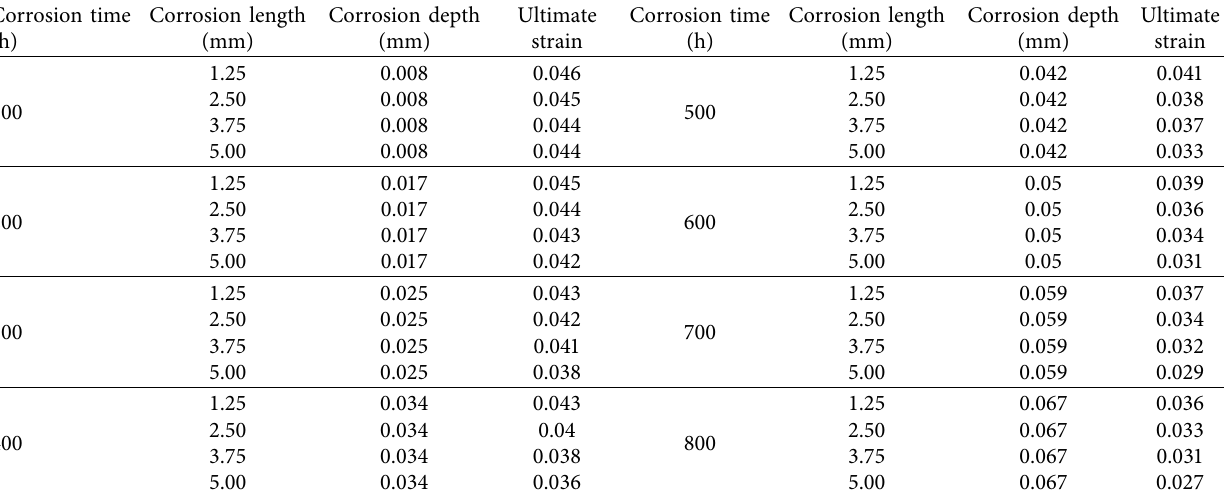
Figure 5: Wire model and meshing diagram. Table 1: Ultimate strain of steel wire under uniform corrosion.